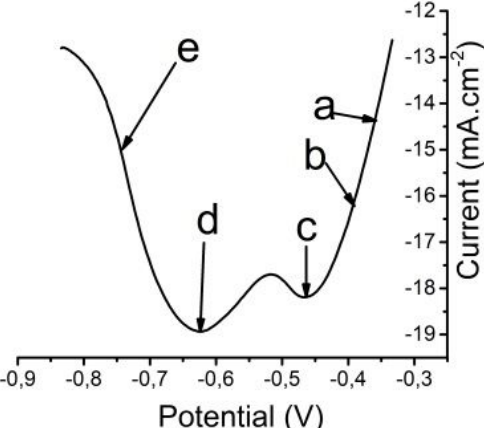
Figure 6. CdTe cyclic voltammetry graph at 50 mV/s -1 scan speed. Source: the author.